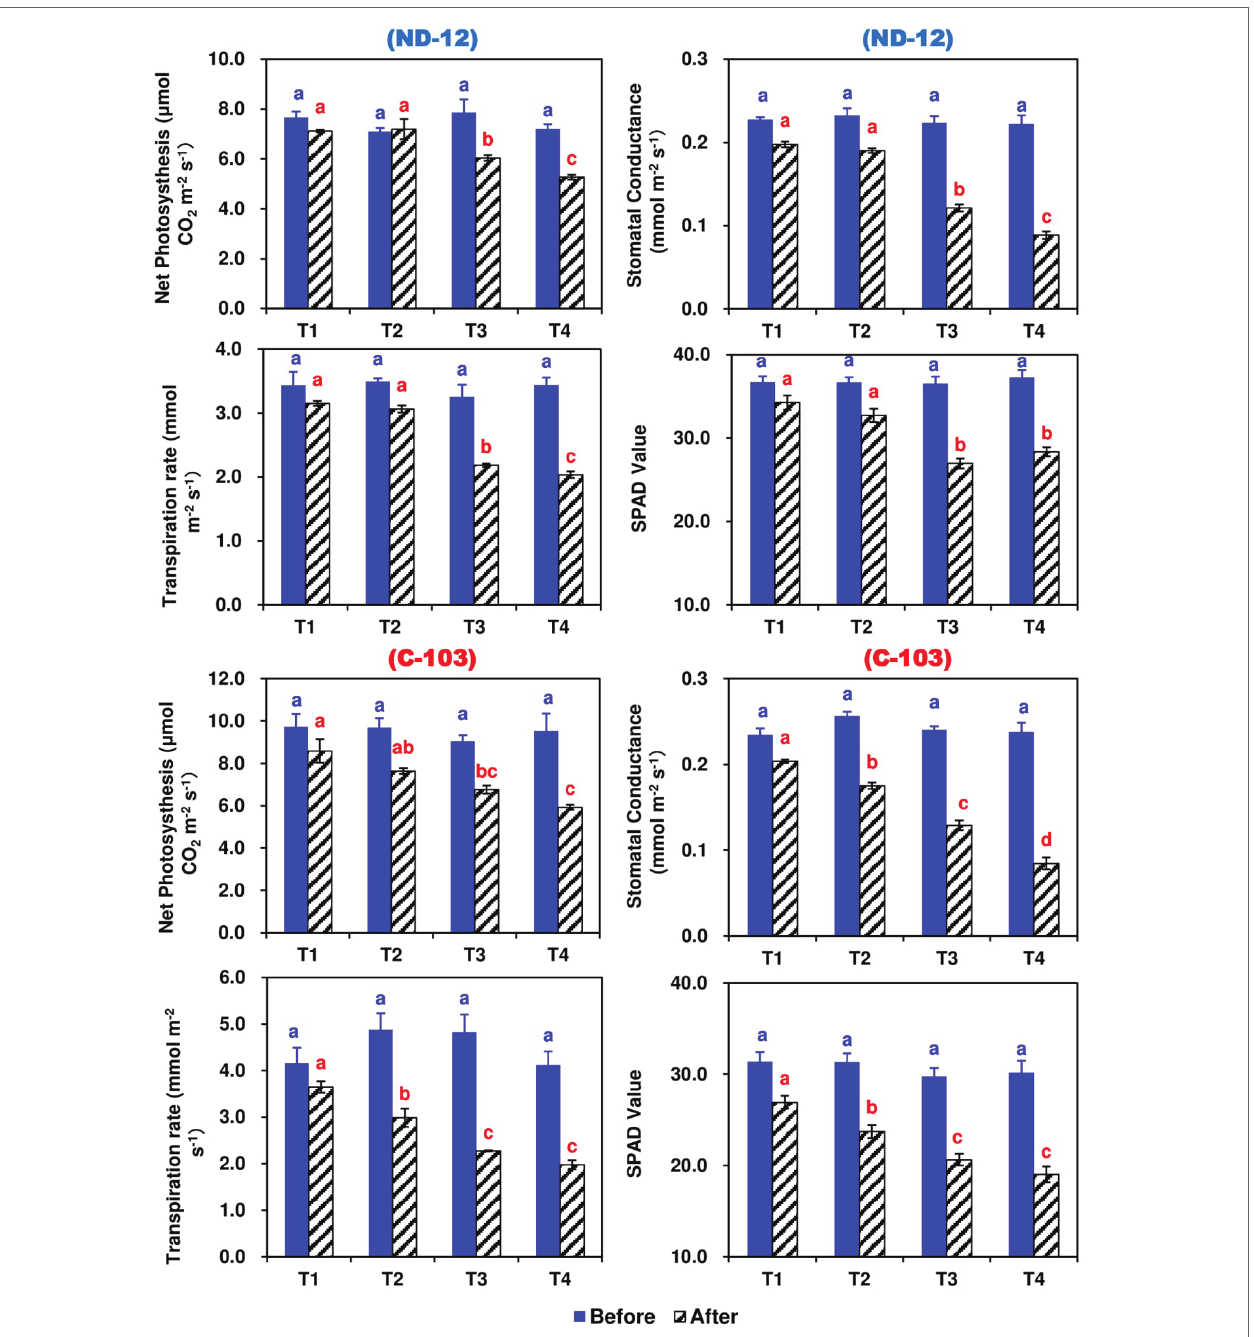
FIGURE 3 | Effect of different split-root PEG treatments on photosynthetic parameters of two soybean cultivars, ND-12 (drought resistant) and C-103 (drought susceptible). (Mean ± SE), same small letters are not significantly different at p < 0.05. T1 (0%: 0%), T2 (2%A: 0%B), T3 (6%A: 0%B), and T4 (4%A: